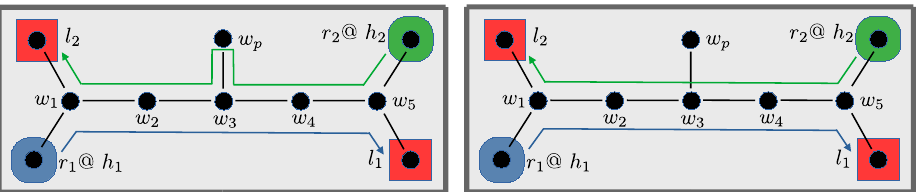
Figure 3. A simple example showing the limitation of the path encoding against the step-based encoding; robot r 1 located at vertex h 1 needs to travel to l 1 , while robot r 2 at h 2 needs to travel to l 2 . For a uniform edge weight of 10 s the walk encoding ( left ) can achieve the optimal makespan of 90 s while the best path encoding plan ( right ) requires 120